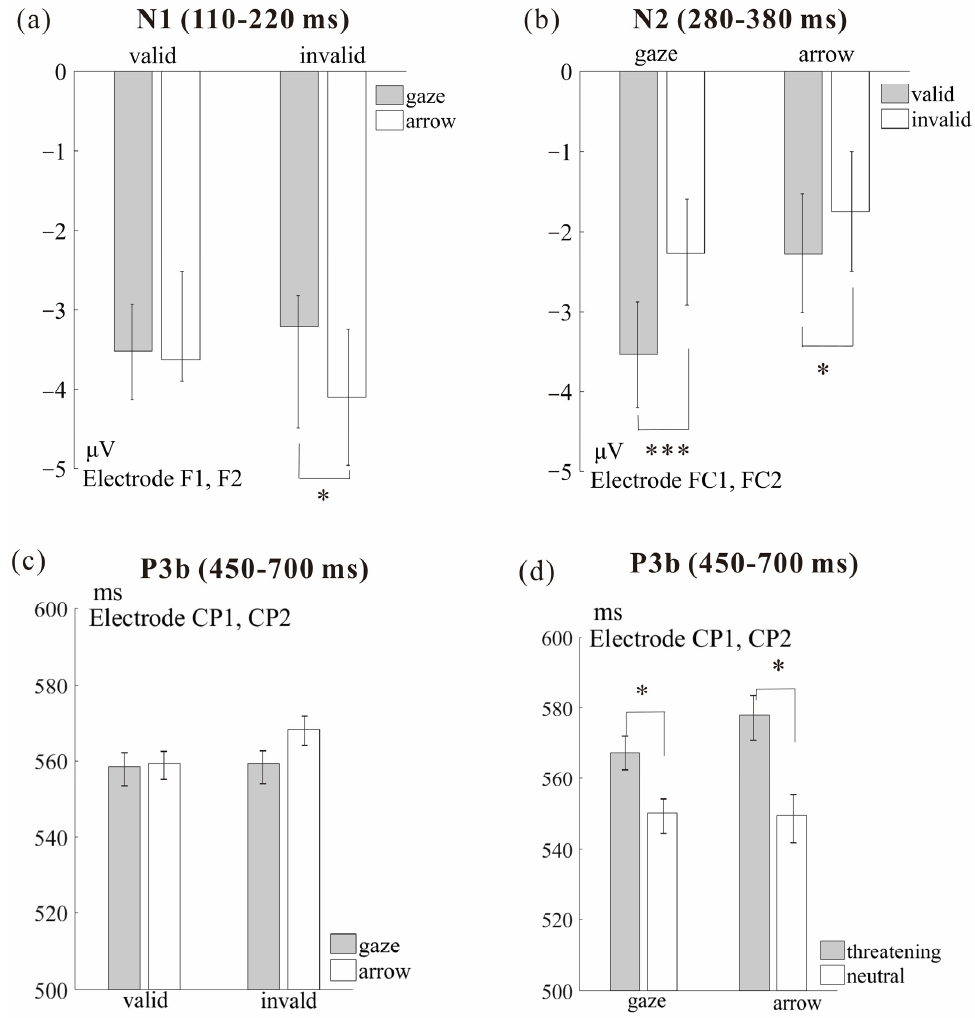
Figure 6. Average amplitudes and standard errors of the target-elicited ( a ) N1 (110–220 ms), ( b ) N2 (280–380 ms). ( c , d ) Mean peak latency and standard errors of the target-elicited P3b (450–700 ms) for the interactions of ( c ) Cue type and Cue validity and ( d ) Cue type and Target type. * p < 0.05. *** p <